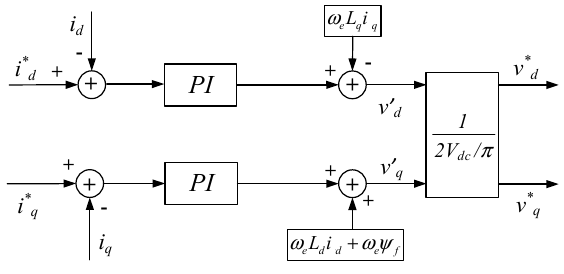
Figure 2. Structure of conventional standard controller.